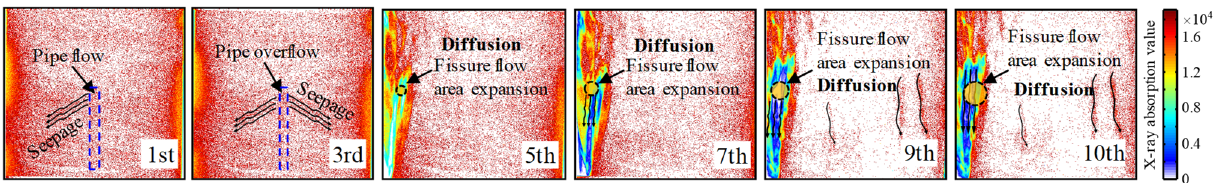
Figure 9. Fissure seepage and diffusion phenomenon in red-bed mudstone failure. Table 4. Calculation Results of the Seepage–Diffusion Coefficient in Mudstone Specimen Failure.